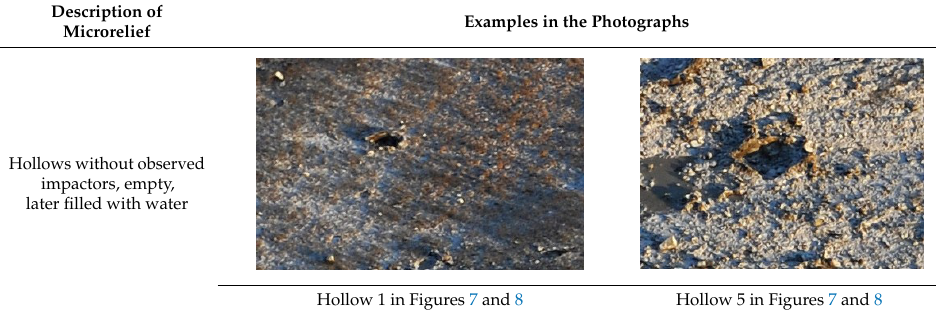
Table 3. Appearance of landforms associated with the formation of GEC-2 in the photographs as of 14 November 2012.